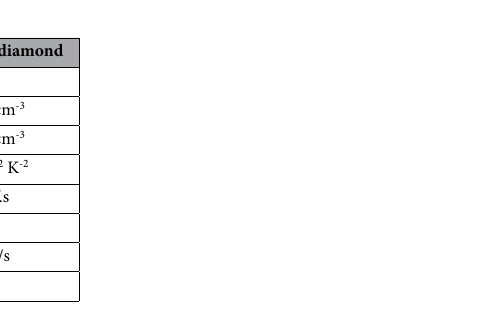
Figure 7. The theoretical modeling of I DS –V DS characteristics of 2DHG diamond MOSFET with negative interface charge model at − 5 × 10 12 cm -2 . The drain current reaches its limitation with gate voltage range V GS = − 60 V. It is caused by the saturation of hole injection by the gate voltage.